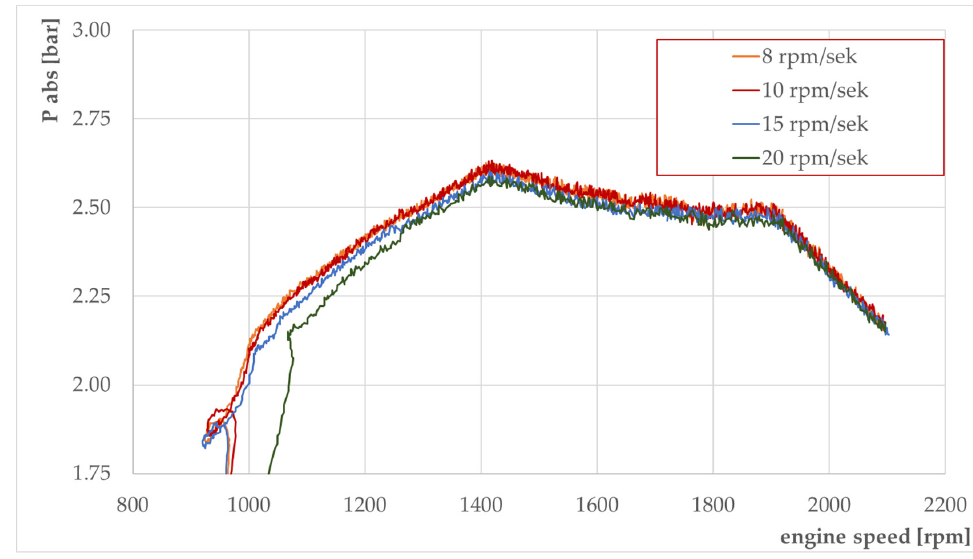
Figure 12. Influence of the coasting-down speed for the test of the external characteristics (maximum torque values) on the boost pressure (authors’ source).